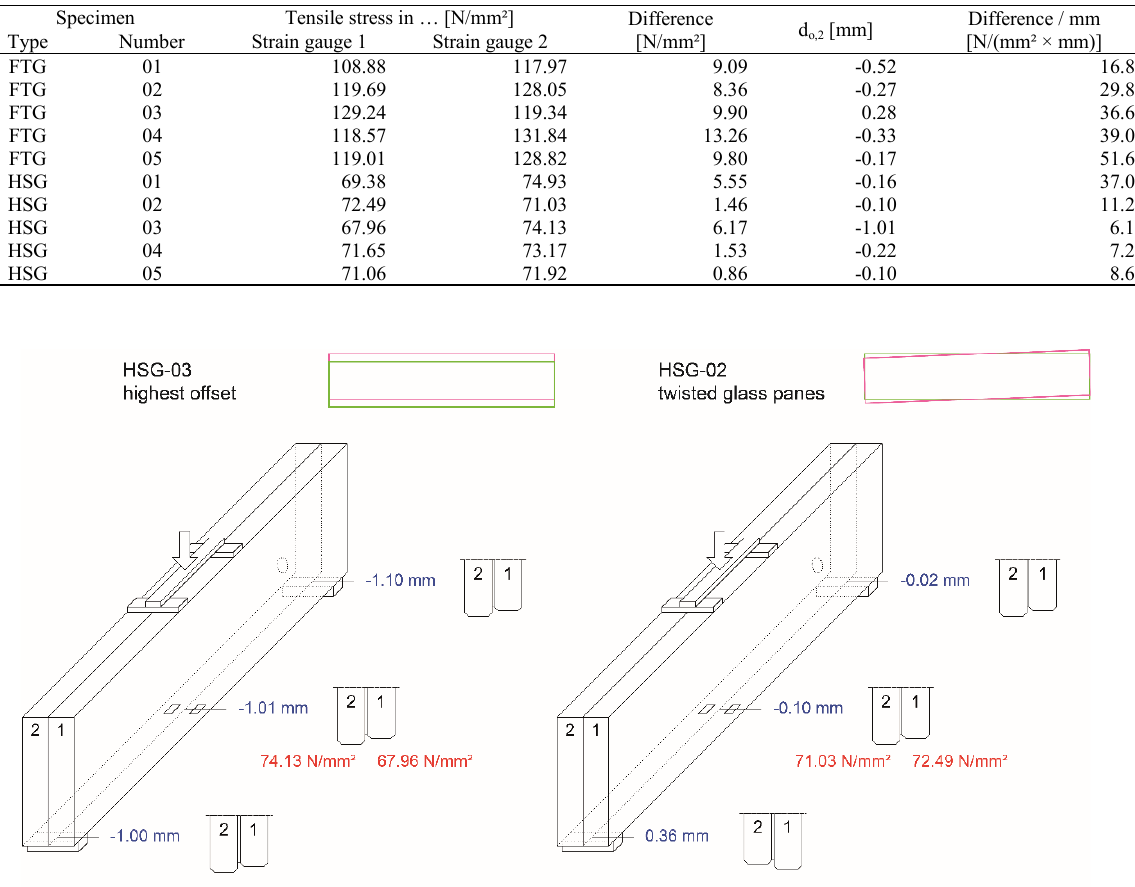
Table 4: Maximum tensile stresses of the non-destructive tests.